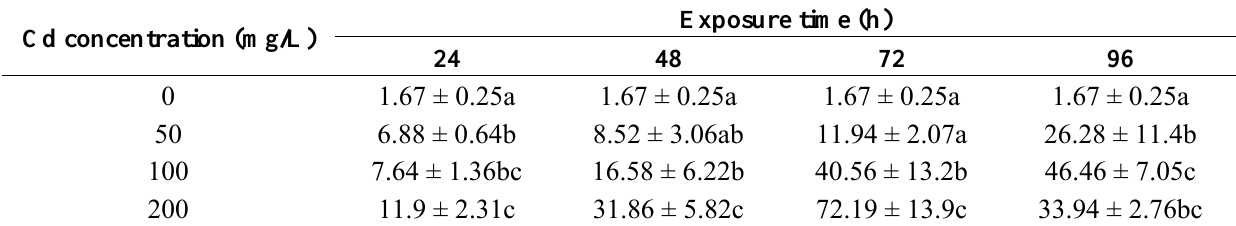
Table 1. Cd concentration in germinating soybean seeds after 24, 48, 72 and 96 h Cd exposure ( μ g/g). Cd concentration (mg/L)